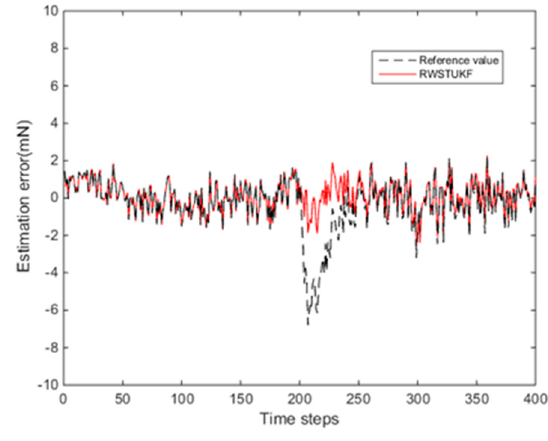
Figure 4. Estimation errors of both UKF and RWSTUKF under local modelling error. Table 3. Estimation errors by both UKF and RWSTUKF under local modelling error.